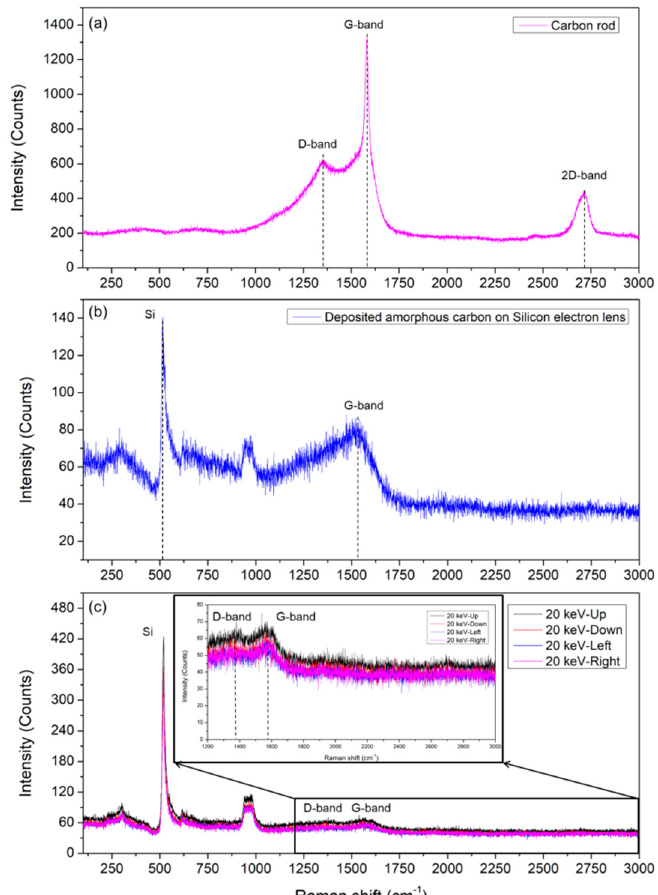
Figure 4. Raman spectra of carbon-related materials. ( a ) Carbon rod; ( b ) amorphous carbon deposited by D.C sputtering on a Si electron lens; ( c ) Si electron lens irradiated with 20 keV (inset: 1200 cm − 1 –3000 cm − 1 ).